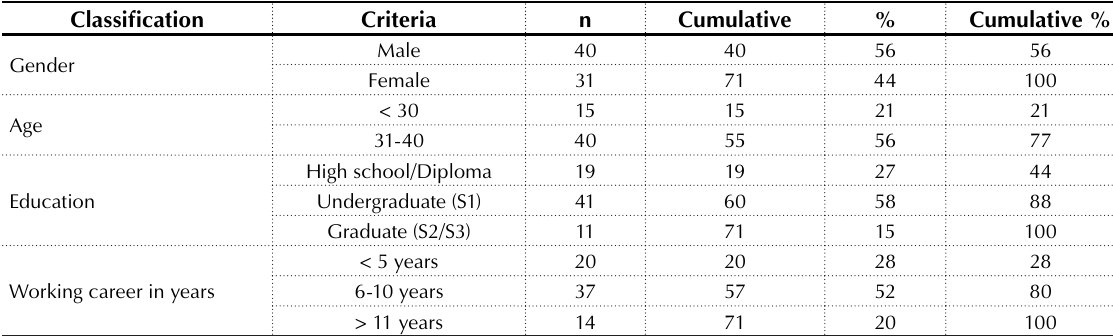
Table 2. Demografic information of